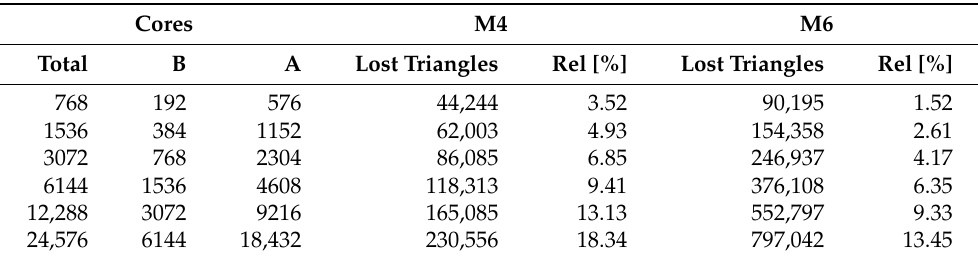
Table 2. Number of triangles of mesh 4 and mesh M6 that are discarded due to the vertex-based partitioning (in absolute and relative values). The original mesh M4 contains 1,257,391 triangles and the original M6 mesh contains 5,924,260